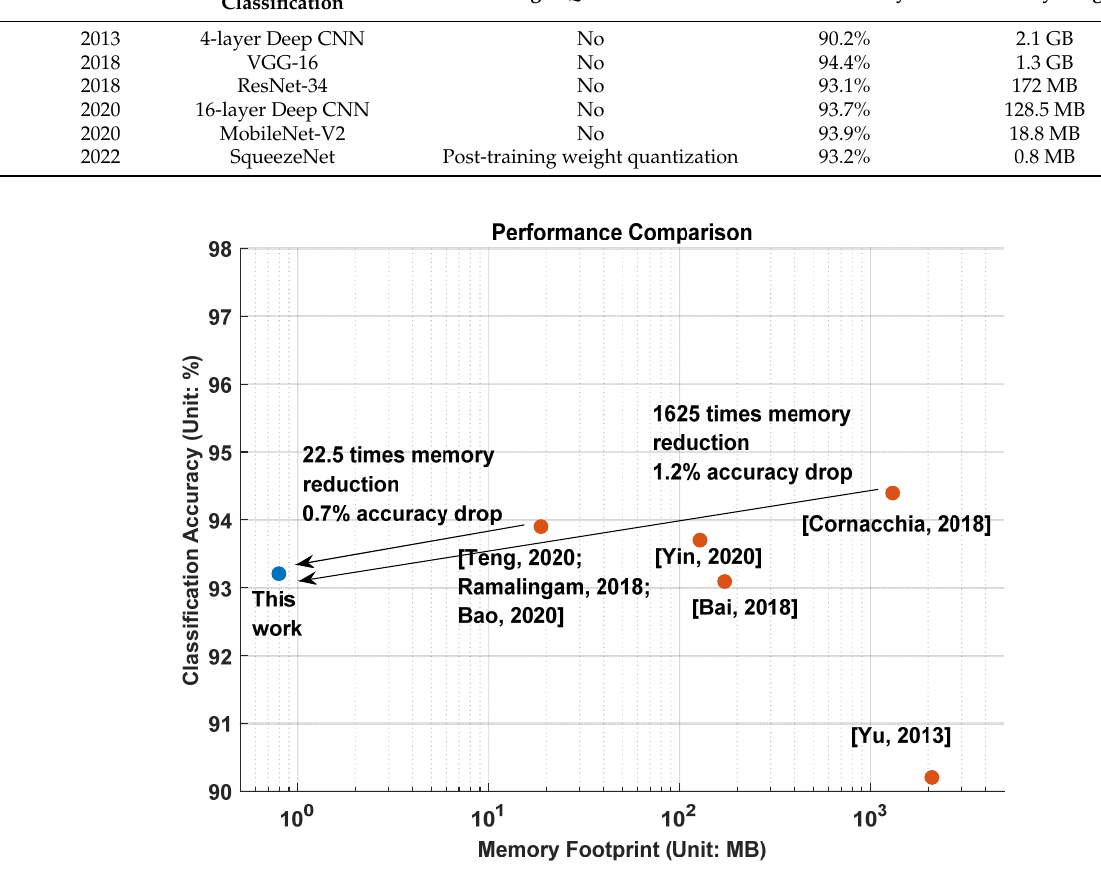
Figure 8. Performance comparison of test accuracy vs. memory footprint between this work and the existing state-of-the-art works [11 – 17] in the literature .